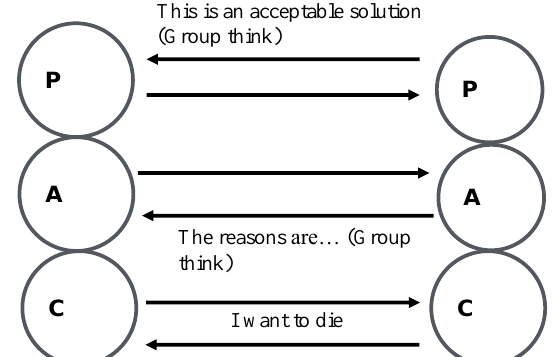
Figure 1: Suicidal Group